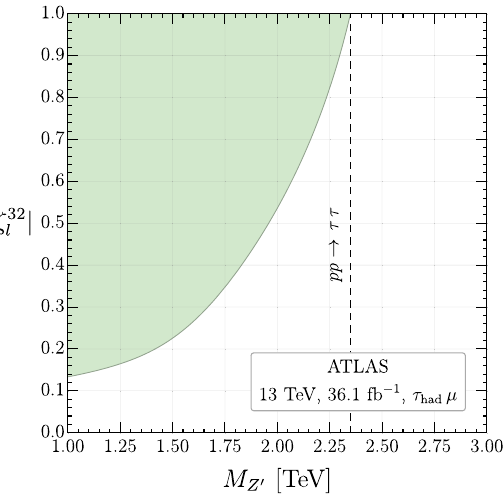
, M ) plane, taking the natural width for Z (cid:2) L